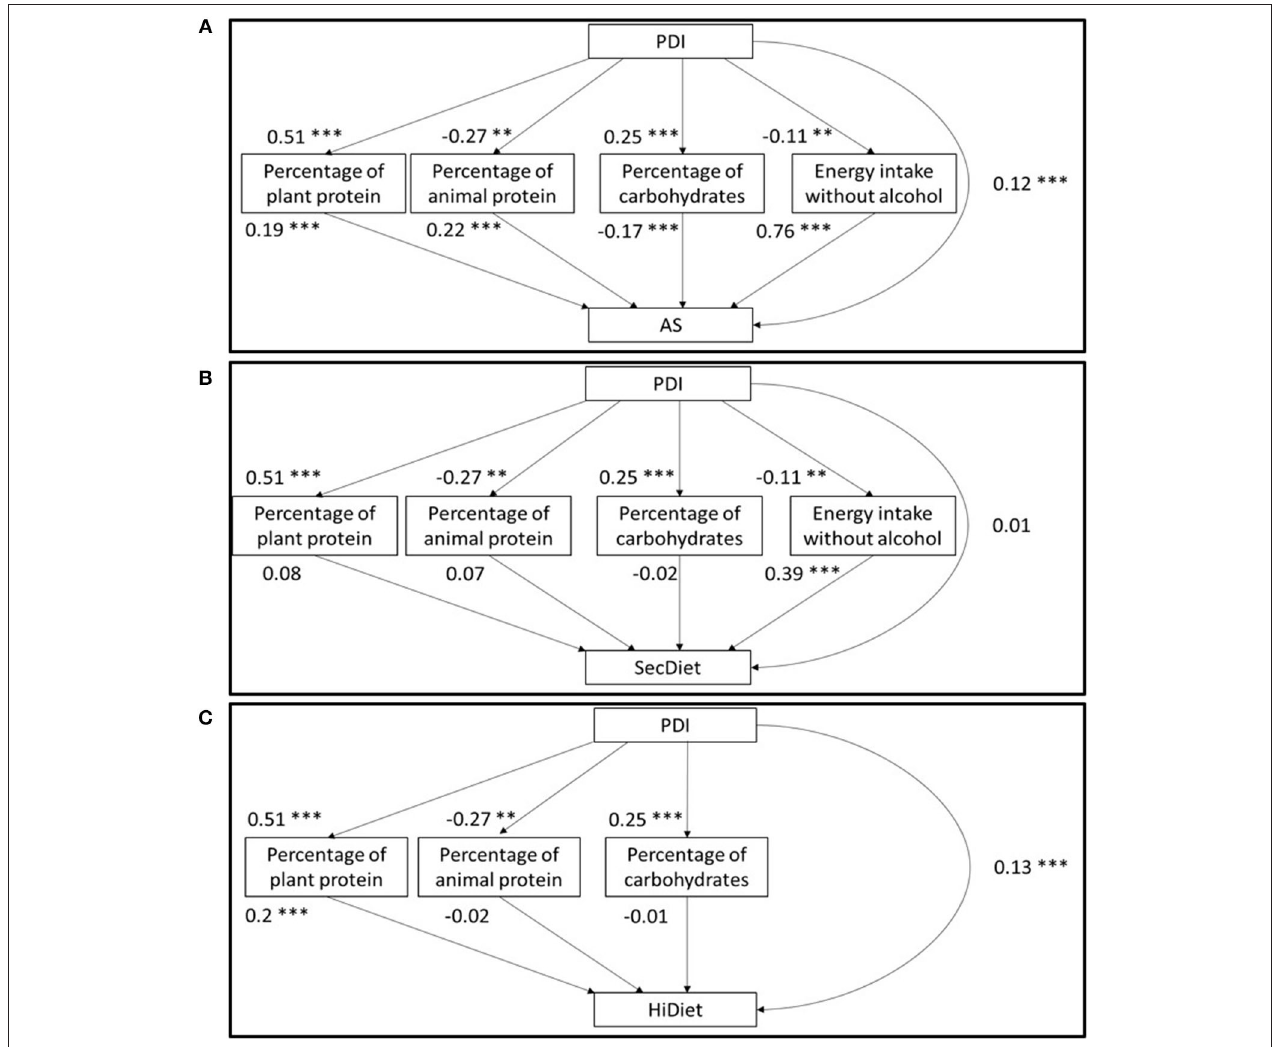
FIGURE 1 | Structural model of the path analyses between the PDI and the AS (A) , SecDiet (B) , and the HiDiet (C) with the percentage of energy from plant and animal proteins, the percentage of energy from carbohydrates, and the energy intake without alcohol as mediators. All regression coefficients are standardized. * P < 0.05, ** P < 0.01, *** P <